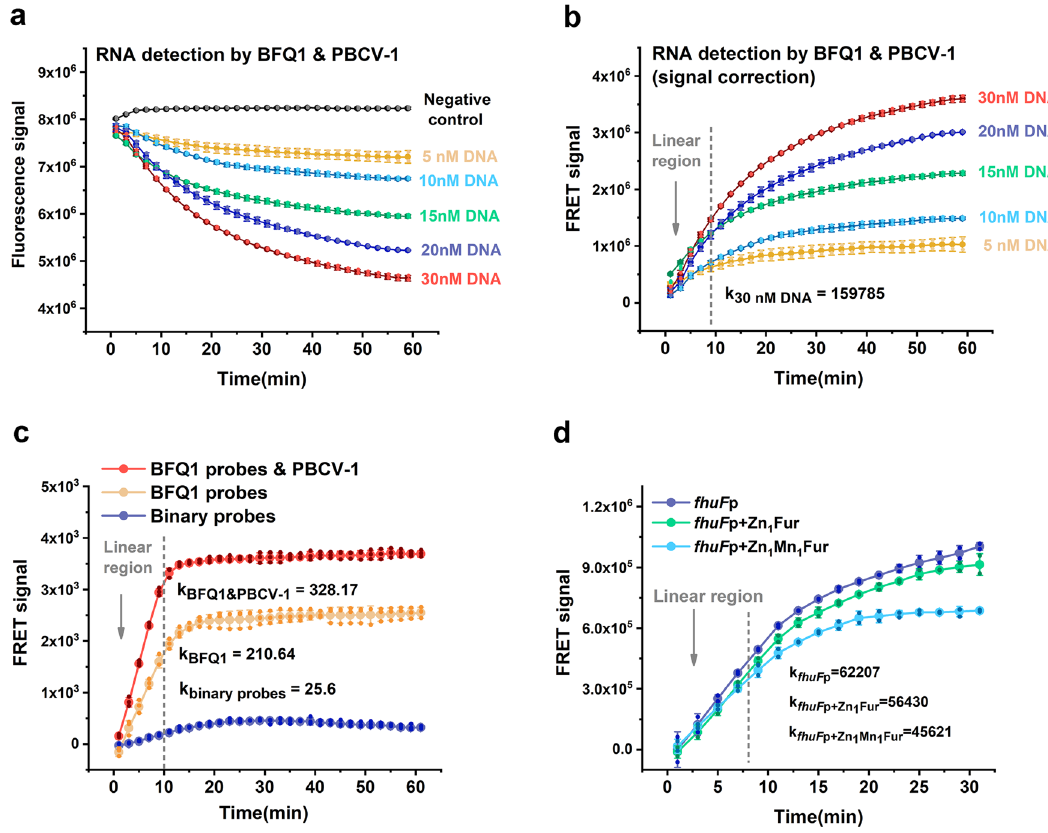
Fig. 3 Real-time quantitative transcription detection assays for BFQ and PBCV-1 DNA ligase. a , b The raw and signal corrected data for T7 RNAp transcription activity. 200 nM T7 RNA polymerase, 5 ‒ 30 nM DNA template 1, 250 µ M NTP mixture, 500 nM BFQ1 (BFQ1a2 and BFQ1b3) and 50 nM PBCV-1 DNA ligase were mixed in transcription buffer and immediately tested in a RT-PCR thermocycler using its FAM scan channels. The initial transcription velocity for the 30 nM DNA template group was measured by fi tting the slope for the 1 ‒ 9 min reaction region. Values are mean ± standard deviation of two repeats. c Comparison of the binary probes and RT-IVT methods. 200 nM T7 RNA polymerase, 30 nM DNA template BFQ1&Binary probes , 250 µ M NTP mixture, and 500 nM binary probes or 500 nM BFQ1 and 50 nM PBCV-1 DNA ligase (added as required) were mixed in transcription buffer and tested in a microplate reader with FAM fl uorescence (excitation 494 nm, emission 522 nm) and Cy3/Cy5 sensitized fl uorescence (540 nm, 680 nm) separately. Values are mean ± standard deviation of three repeats. d The RT-IVT method can be used for detection of transcriptional repression activity for Fur. 250 nM E. coli RNA polymerase holoenzyme, 30 nM DNA template fhuFp , 250 µ M NTP mixture, 250 nM BFQ1 (BFQ1a2 and BFQ1b3), 50 nM PBCV-1 DNA ligase and 500 nM Zn 1 Fur or Zn 1 Mn 1 Fur were mixed in transcription buffer and tested immediately in a RT-PCR thermocycler using its FAM scan channels. Values are mean ± standard deviation of two